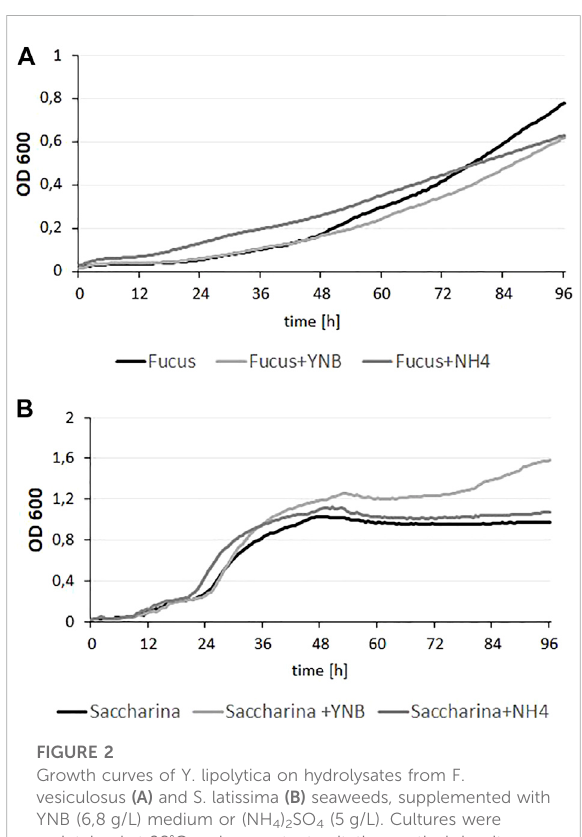
FIGURE 1 Effect of different treatment conditions on glucose and mannitol release from F vesiculosus biomass hydrolysate. (A) “ acidic vs. no acidic ” treatment of hydrolysate before enzymatic digestion, (B) effect of biomass load and enzyme Cellic CTec2 dosage.